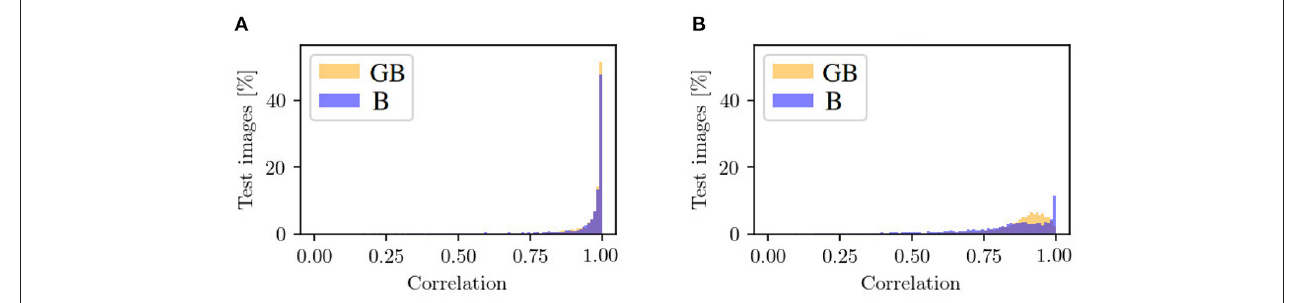
x occ in the occluded e